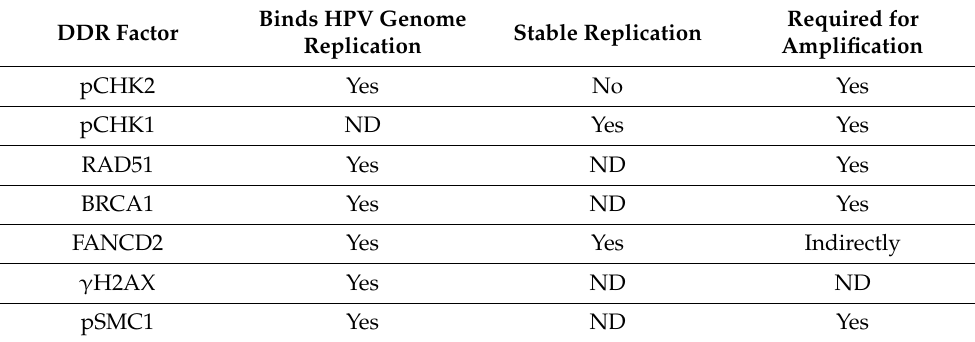
Table 1. List of DDR factors activated in HPV positive cells and their roles in binding of viral genomes, stable maintenance replication in undifferentiated cells and amplification upon differentiation. ND: not